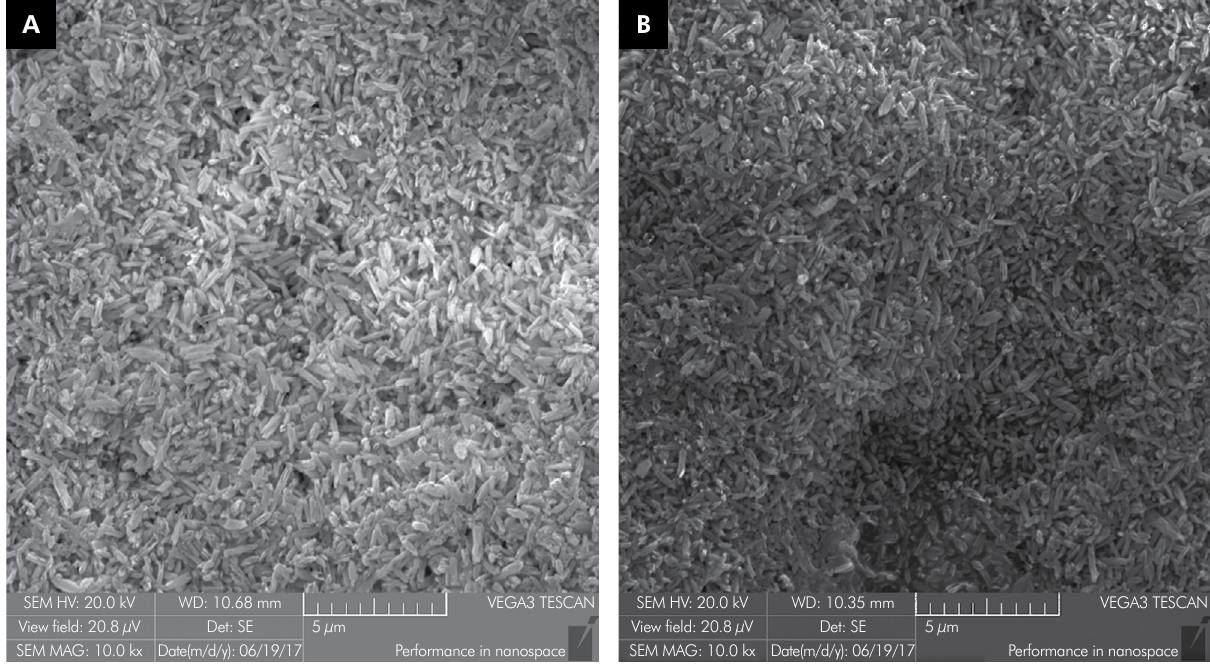
Figure 2. SEM images: A: IPS e.max CAD group after etching, 10,000× magnification; B: Rosetta SM group after etching, 10,000× magnification.